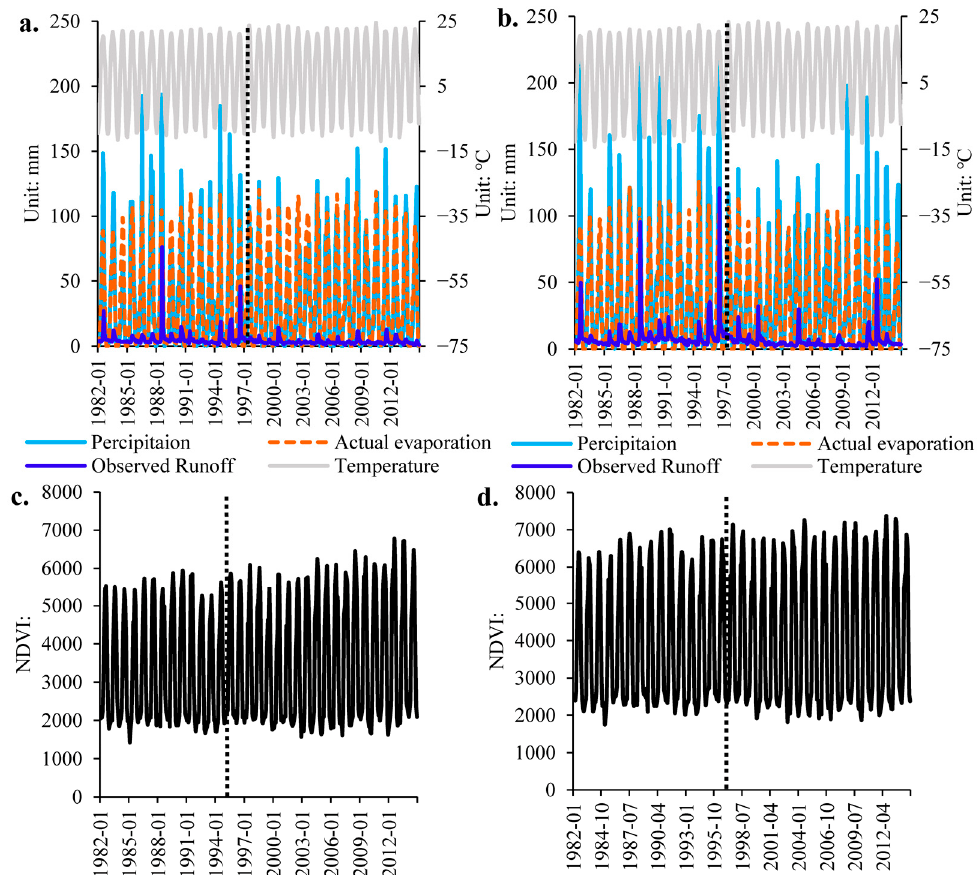
Figure 3. ( a ) Monthly trends of precipitation (mm), actual evapotranspiration (mm), runoff (mm), and air temperature (°C) from 1982 to 2014 in the Daomaguan basin; ( b ) monthly trends of precipitation, actual evapotranspiration, runoff, and air temperature from 1982 to 2014 in the Zijinguan basin; ( c ) monthly trends of NDVI from 1982 to 2014 in the Daomaguan basin; ( d ) monthly trends of NDVI from 1982 to 2014 in the Zijinguan basin. Table 1. Results of MK trend analysis for precipitation, air temperature, actual evapotranspiration, NDVI and runoff. The “*” represents the significant trend.